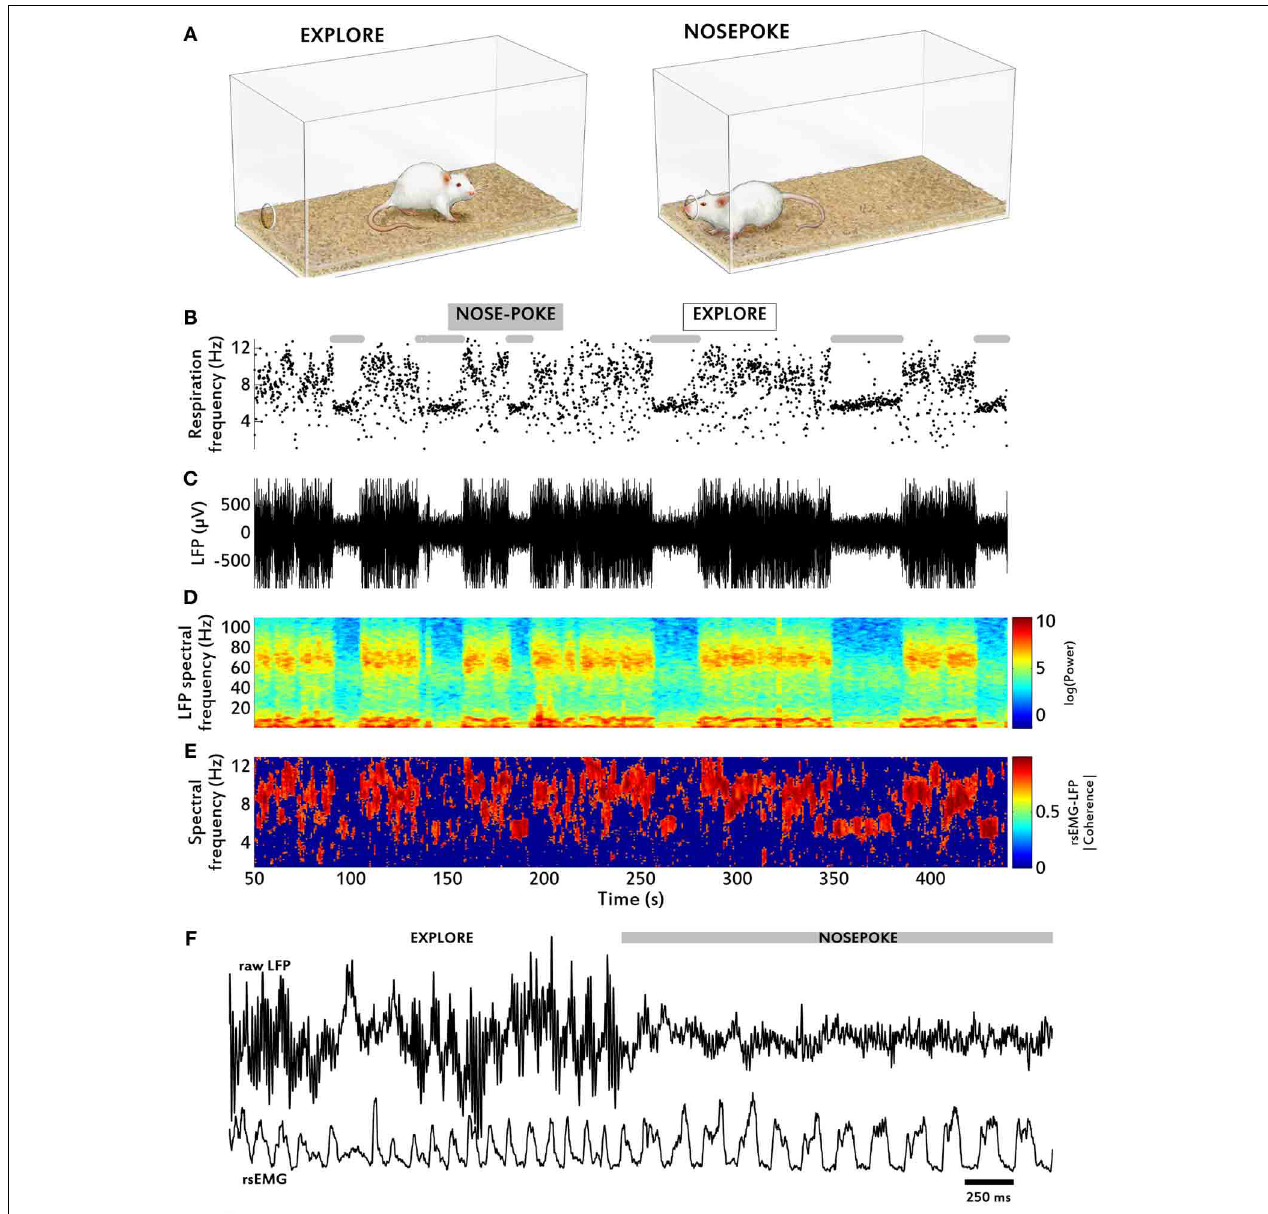
FIGURE 7 | Behavioral modulations of the sensory-motor coupling. (A) Rats displayed two main behaviors: remaining still and poking the nose at a hole in the cage wall (“NOSEPOKE”) or actively exploring the cage (“EXPLORE”). (B) Respiratory frequency time series, calculated from diaphragm EMG; note the large variance in frequency during exploratory periods relative to nose-poke periods (marked by gray bars). (C) Raw LFP time series. Note the much larger amplitudes, which represent primarily theta